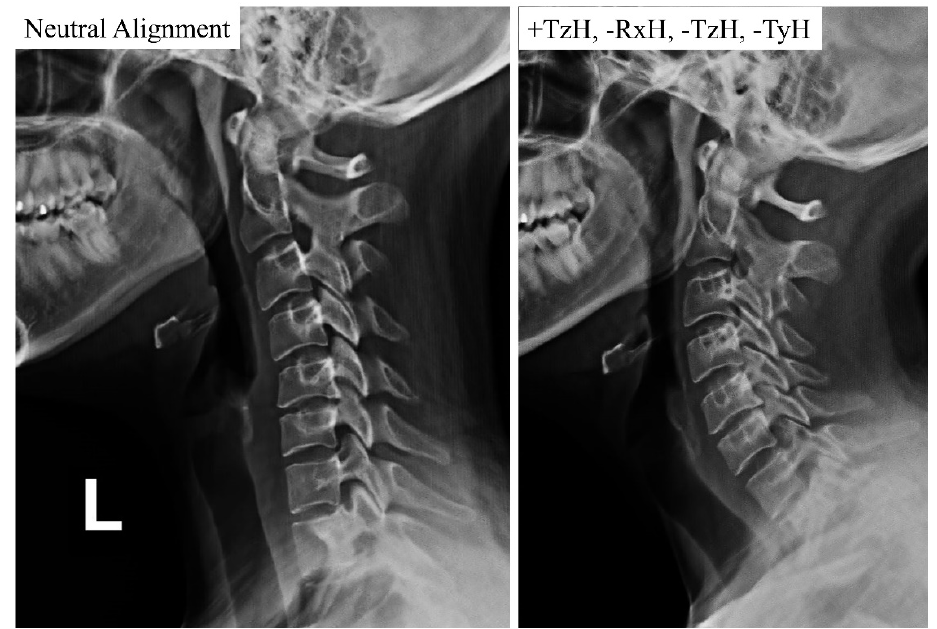
Figure 3. A patient’s lateral cervical x-rays are shown in neutral and after the mirror image exercise sequence (+TzH, − RxH, − TzH, − TyH) demonstrating the change in alignment from neutral with this sequence of movements: forward head posture (+TzH), upper neck / head extension ( − RxH), followed by posterior head translation ( − TzH) with an inferior compression component ( − TyH). Images courtesy of Curtis Fedorchuk, reprinted with permission [28,29].